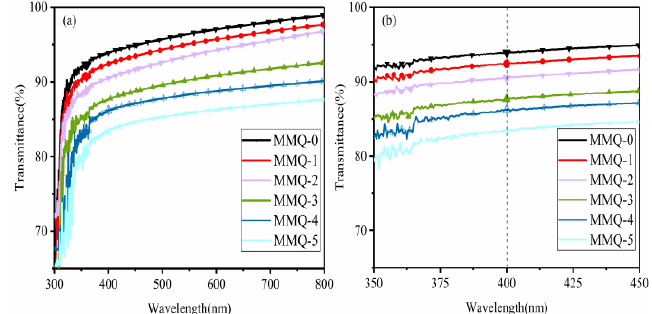
Figure 8. The UV-transmittance of RTV silicone rubber ( a ), and ( b ) the spectrogram of the spectra from 350 nm to 450